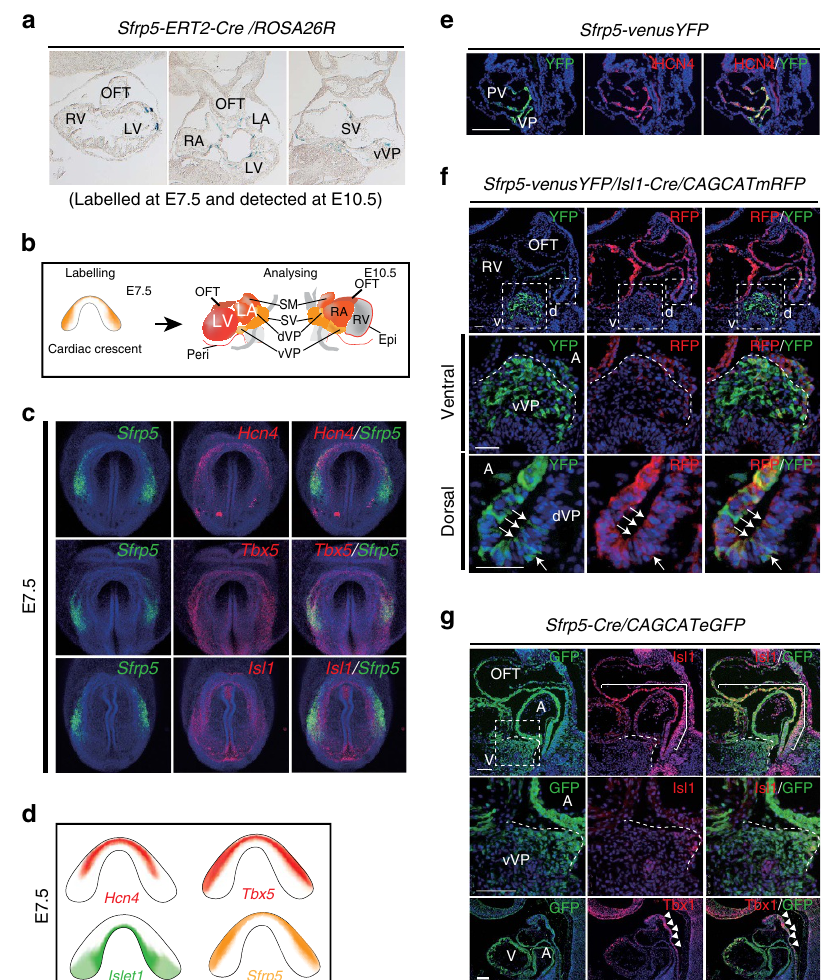
Figure 3 | Sfrp5- expressing cells at E7.5 contribute to the SV and all chamber myocardium except for the RV. ( a ) Representative photographs of LacZ-stained sections from Sfrp5-ERT2Cre / Rosa-lacZ embryos at E10.5, labelled by tamoxifen at E7.5. ( b ) Schematic drawing for the expression of Sfrp5 (orange) and the cardiac contribution of its lineages (red) when cells were labelled at E7.5 and analysed at E10.5. ( c ) Double fluorescent whole-mount ISH of mouse embryos at E7.5 for detection of Sfrp5 (green) and Hcn4 , Tbx5 or Isl1 (red), as indicated in each panel. ( d ) Schematic drawings of gene expression of Sfrp5 , Isl1 , Hcn4 and Tbx5 . ( e ) Double immunohistochemistry of Sfrp5-venusYFP at E8.5 using anti-GFP (green) and anti-HCN4 (red) antibodies. Co-expression with HCN4 was found in the VP. Weak expression of YFP also co-distributed with HCN4-positive cells in the IFT and part of the primitive ventricle (PV). ( f , g ) Double immunohistochemistry of Sfrp5-venusYFP ( e ), Sfrp5-venusYFP/Isl1 - Cre / CAG-(floxed)-CAT-mRFP ( f ) or Sfrp5 - Cre / CAG-(floxed)-CAT-eGFP ( g ) embryos at E9.5 using anti-GFP (green) antibodies and anti-HCN4, anti-RFP, anti - Isl1 or anti-Tbx1 (red) antibodies. Rectangles in upper panels are magnified in lower panels (v: ventral; d: dorsal). Co-expression with Isl1 was detected (arrows in panel ( f ) and parenthesis in panel ( g )). Boundaries for the VP from the atrium are indicated by white dotted lines ( f , g ). Signal for Tbx1, but not GFP, was observed in the anterior splanchnic mesoderm and anterior OFT (arrowheads in panel ( g )). A,